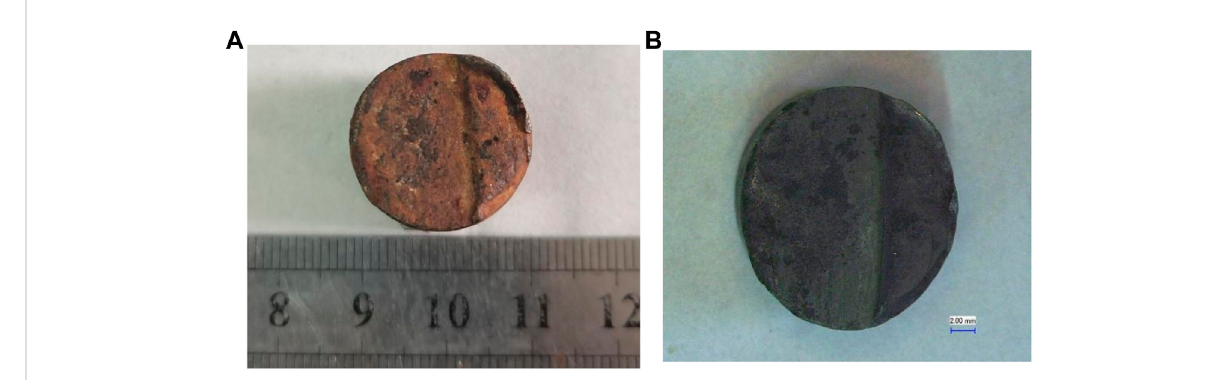
FIGURE 4 Before and after fracture cleaning of specimen No. 1. (A) Before fracture cleaning. (B) After fracture cleaning.